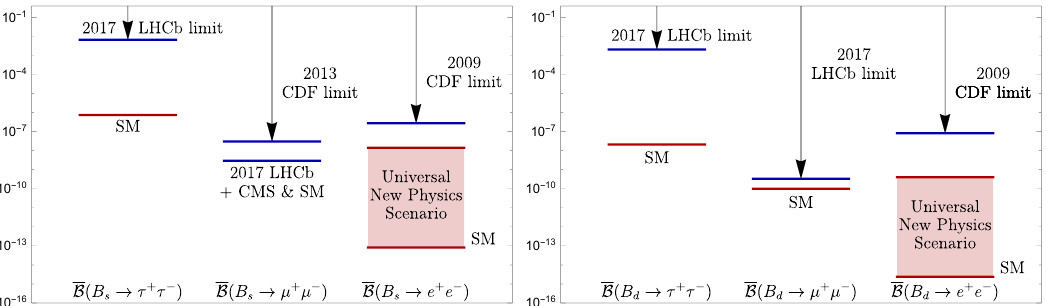
Figure 1 . Illustration of the B 0 ‘ + ‘ (cid:0) (left panel) and B 0 ‘ + ‘ (cid:0) (right panel) branching s ! d ! ratios: current experimental status, SM predictions and the possible enhancement within the general (cid:13)avour-universal NP scenario discussed in the